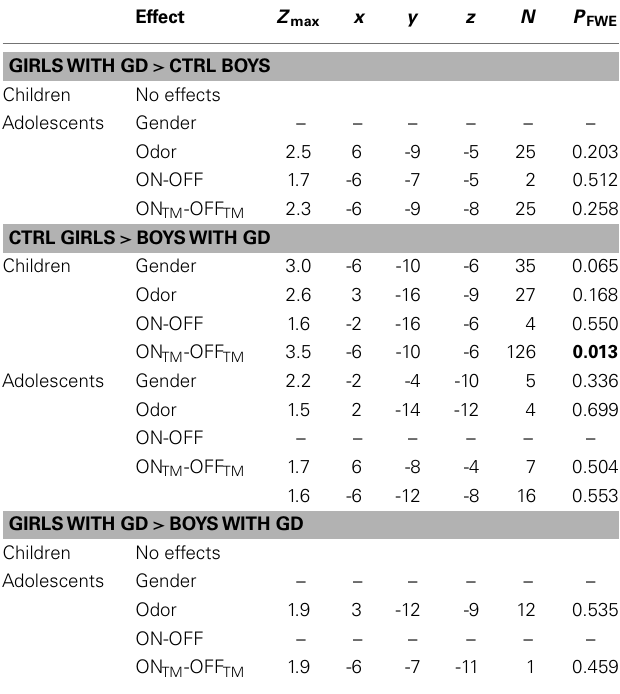
Table 3 |ANOVA results showing sex-typical hypothalamic activations, reflecting their natal sex, in individuals with GD